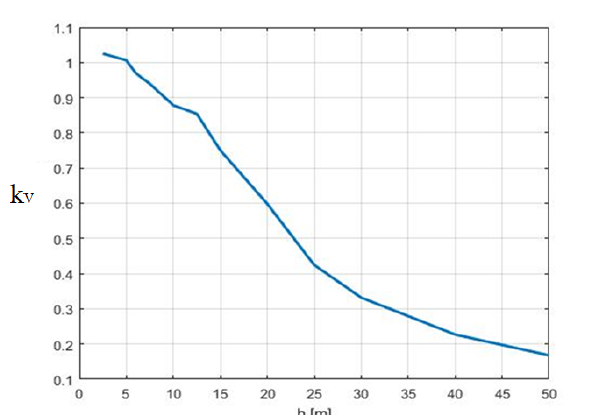
Figure 10. Ratio between the maximum voltage induced on the line considering or not considering the presence of a building. (B) H = 5 m, and d varies from 5 to 200 m.